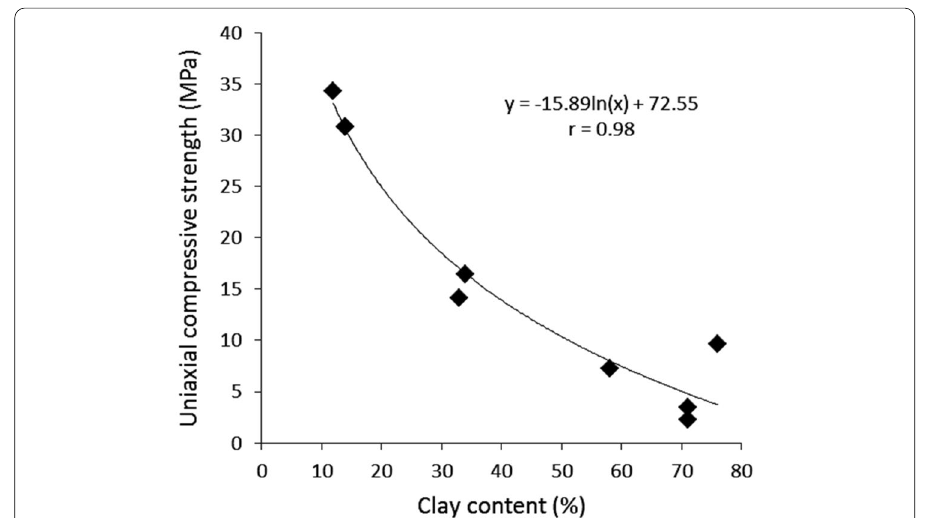
Fig. 12 Correlation between the UCS and the total clay content